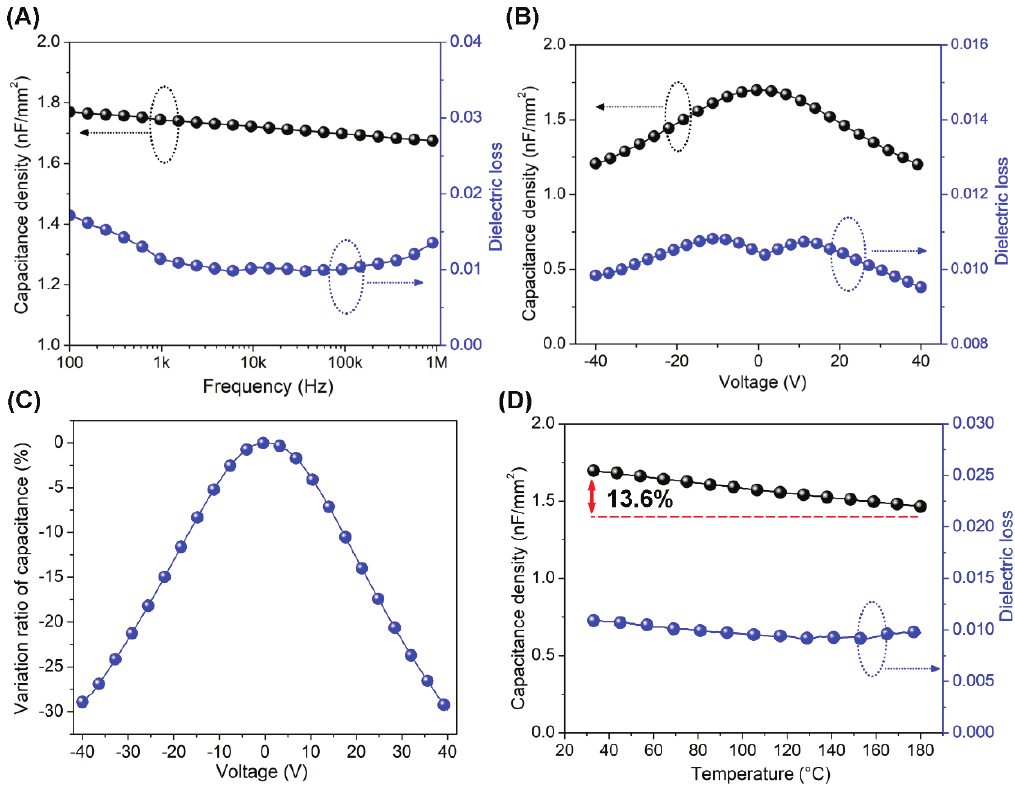
Figure 2. The capacitance properties of the BSZT films. ( A ) The capacitance density and dielectric loss as a function of frequency. ( B ) Direct Current (DC) voltage dependence of capacitance density and dielectric loss. ( C ) The relative variation ratio of capacitance density as a function of DC voltage. ( D ) The capacitance density as a function of testing temperature in the range of 30~180 °C.